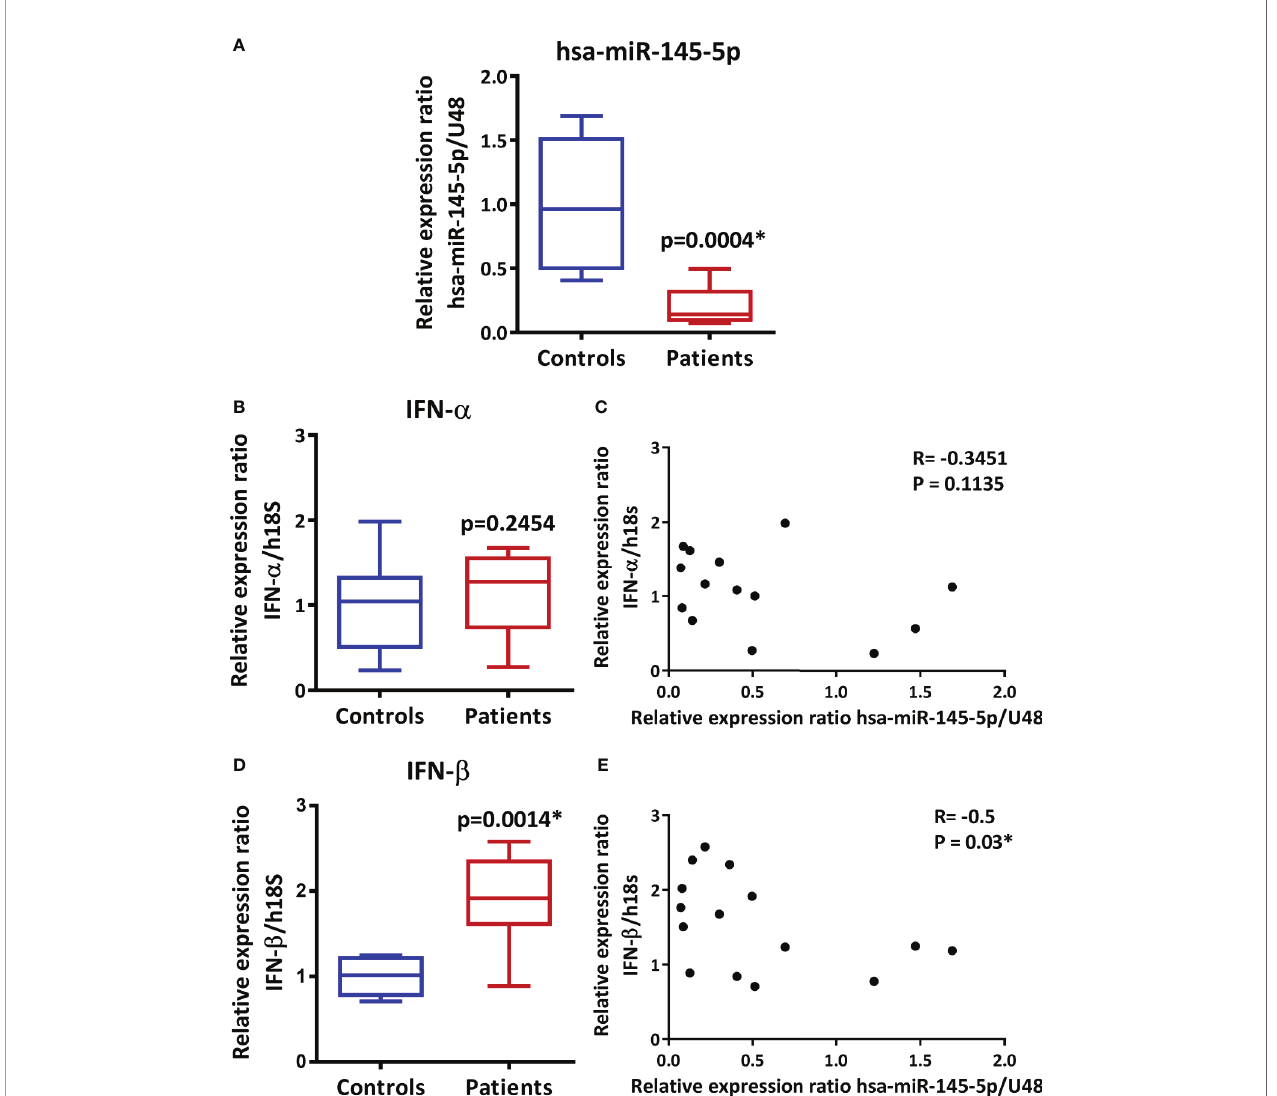
FIGURE 1 | hsa-miR-145-5p is downregulated in LSG from SS-patients and inversely correlates with IFN- b mRNA levels. (A) hsa-miR-145-5p levels in SS-patients (n=9) and control subjects (n=6). U48 snRNA was used as a housekeeping. (B) IFN- a transcript levels in SS-patients and control subjects. h18S was used as a housekeeping gene. (C) Spearman correlation between hsa-miR-145-5p and IFN- a mRNA levels in SS-patients and controls. (D) IFN- b transcript levels in SS- patients and control subjects. h18S was used as a housekeeping gene. (E) Spearman correlation between hsa-miR-145-5p and IFN- b mRNA levels in SS-patients and controls. Data are representative of at least three independent measurements. (*) p-value ≤ 0.05 was considered signi fi